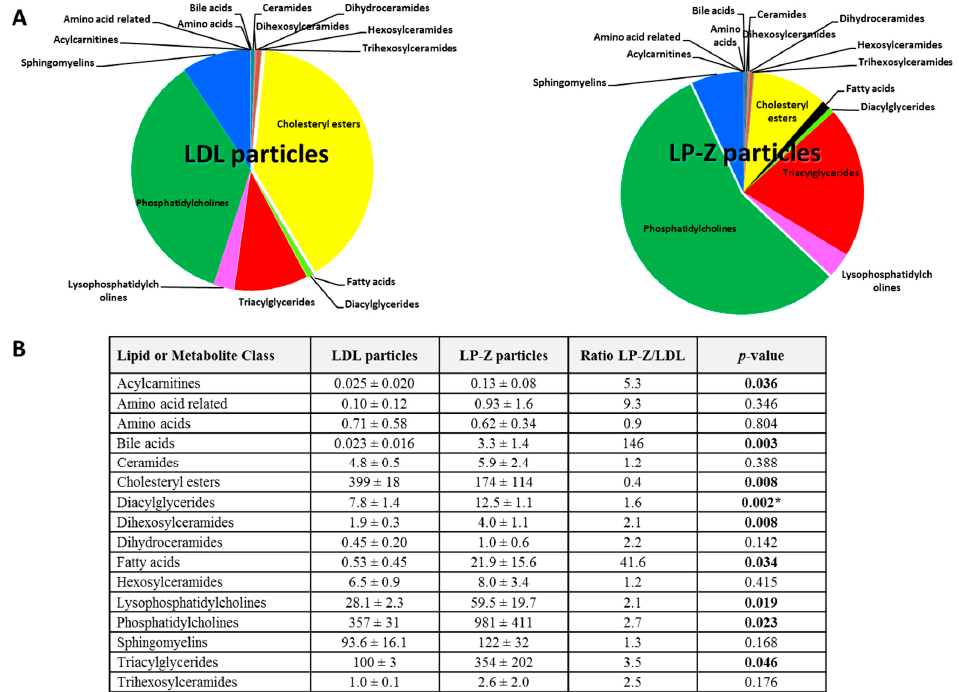
Figure 5. Targeted lipidomic and metabolomic data for isolated LP-Z ( n = 4) versus LDL particles ( n = 4). ( A ) Data expressed as mean (µM) ± standard deviation. Values were normalized to apolipoprotein B content. P values < 0.05 are in bold. ( B ) The p -value threshold with Bonferroni correction = 0.003. * Significant when taking into account Bonferroni correction. Abbreviations: LDL, low-density